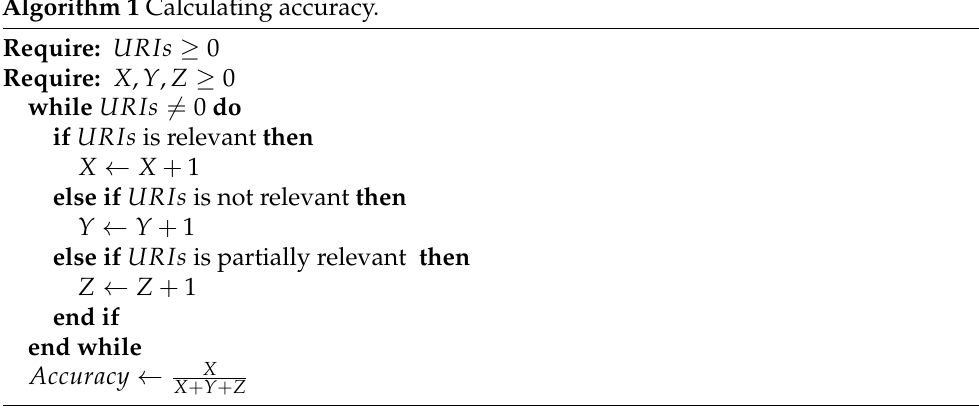
Algorithm 1 Calculating accuracy.